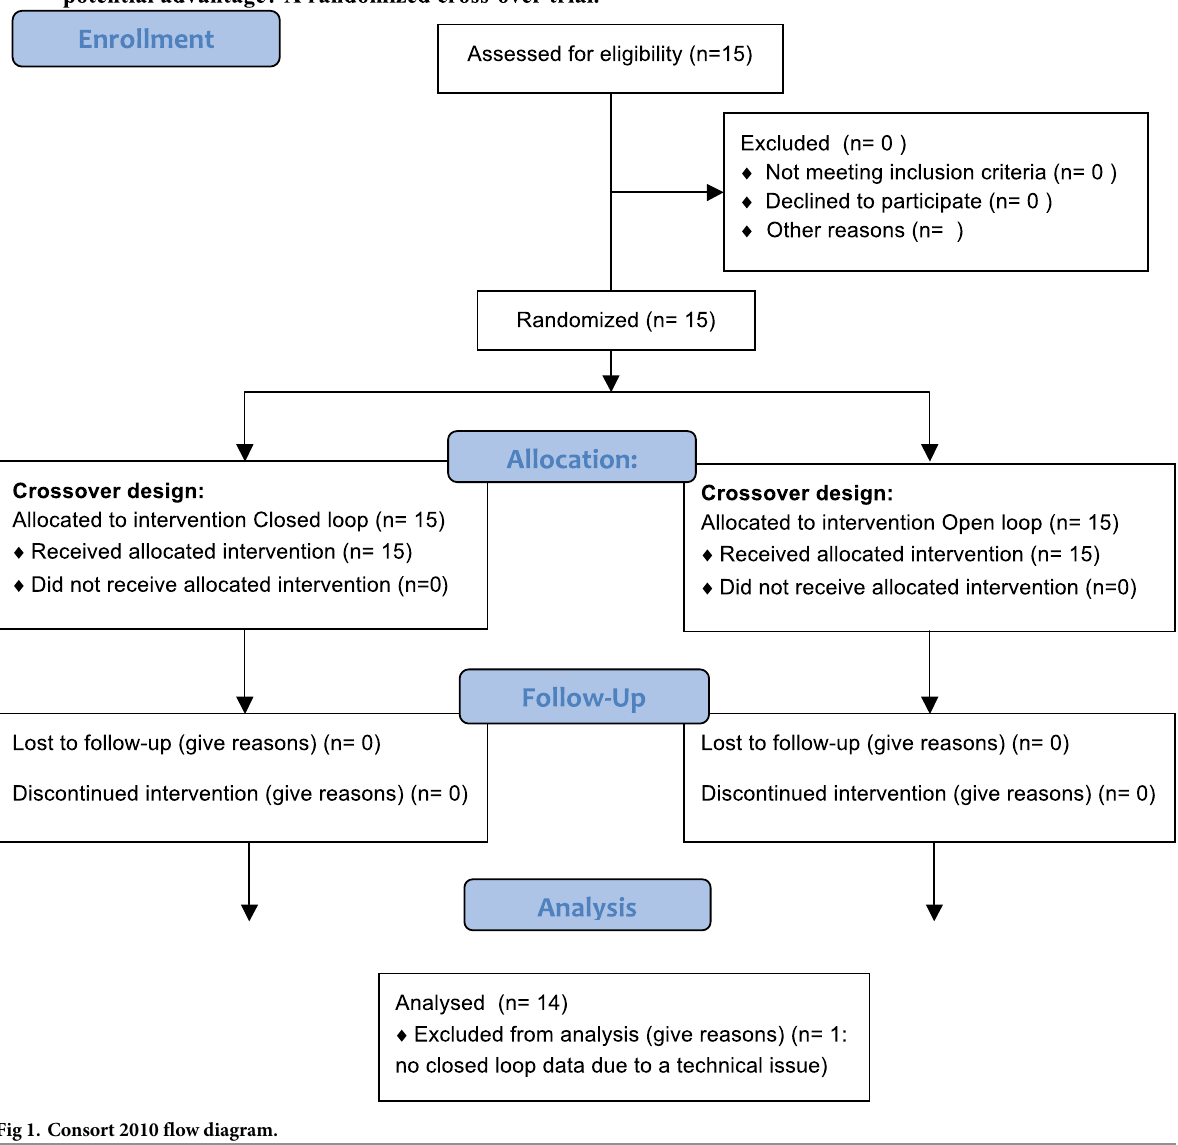
Fig 1. Consort 2010 flow diagram.